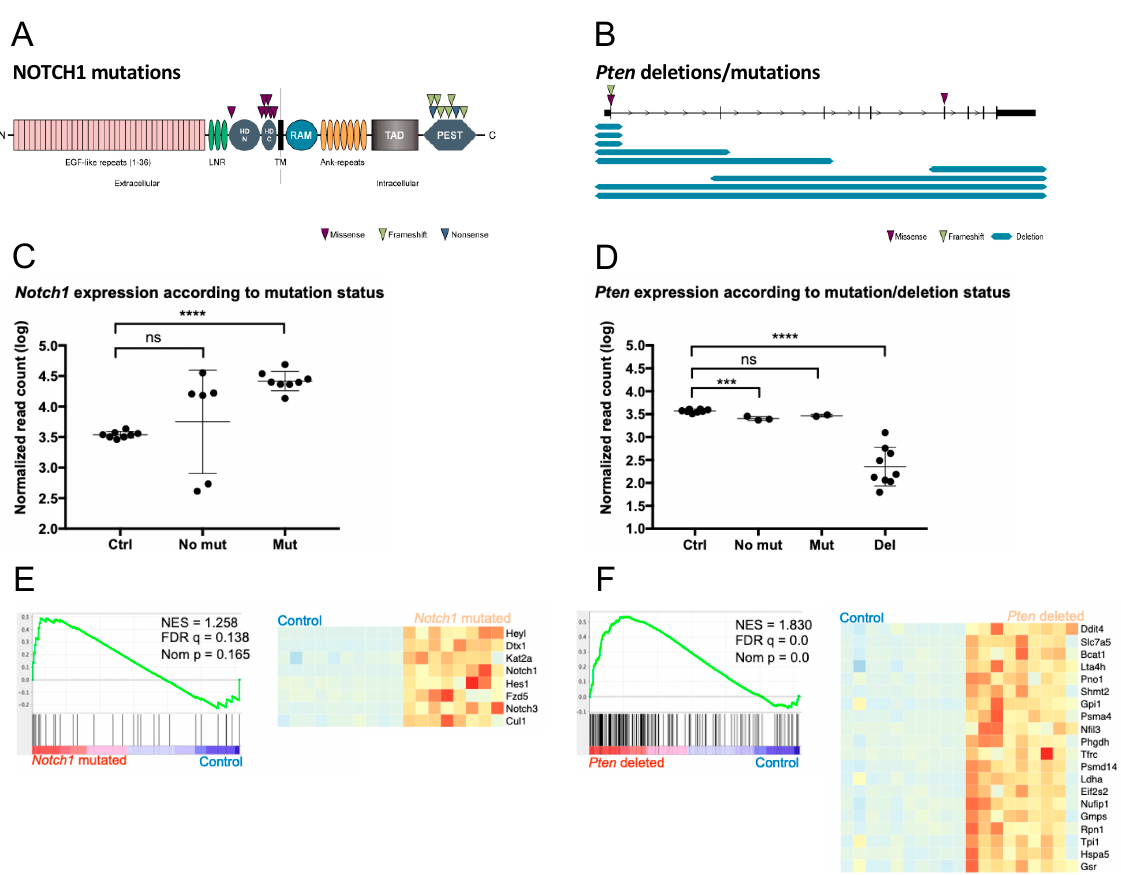
Figure 3. PPM1D -induced thymic lymphomas show typical Notch1 and Pten aberrations. ( A ) Schematic overview of the NOTCH1 protein showing the distribution of mutations in 15 whole-exome sequenced lymphomas. Purple triangles in- dicate missense mutations in the intracellular heterodimerization (HD) domain, whereas green and blue triangles indicate frameshift or nonsense mutations in the extracellular PEST domain. LNR, Lin/NOTCH repeats; HD, heterodimerization domain; TM, transmembrane domain; RAM, RBP-JK-associated molecule region; TAD, transactivation domain; PEST, se- quence rich in proline, glutamic acid, serine, and threonine. ( B ) Diagram of the Pten gene showing the size and distribution of Pten deletions/mutations in lymphomas. The locations of the point mutations are shown with purple and green triangles above the gene diagram. The blue lines below the gene diagram show the size of the deletions identified by exome se- quencing. ( C ) Expression of the Notch1 transcript in controls and tumors with and without Notch1 mutation. The y axis shows the log value of the number of RNA-seq reads mapping to the Notch1 gene. The difference between controls and tumors without Notch1 mutations is not significant (ns), whereas Notch1 expression is significantly higher in the mutated tumors (adjusted p value < 0.0001; Bonferroni multiple comparisons test). ( D ) Expression of Pten in controls and tumors with and without Pten mutation/deletion. Expression is significantly lower in tumors harboring deletions than in controls (adjusted p value 0.0001, Bonferroni multiple comparisons test). ( E ) Gene set enrichment analysis comparing Notch1 mu- tated tumors to controls demonstrated a significant upregulation of genes related to Notch signaling (MSigDB ”Hall- marks” gene set). Left panel: Enrichment plot from GSEA. Right panel: Heatmap showing the expression (z scores) of core enriched genes. Red color indicates positive z scores; blue color indicates negative z scores. ( F ) Gene set enrichment anal- ysis comparing Pten deleted tumors to controls demonstrated upregulation of genes related to the Mtorc1 pathway (MSigDB “Hallmarks” gene set). Left panel: Enrichment plot from GSEA. Right panel: Heatmap showing the expression (z scores) of the top 20 core enriched genes. Red color indicates positive z scores; blue color indicates negative z scores. 3. Discussion Aberrant expression of PPM1D caused by chromosomal gains, gene amplification, or activating mutations has been described in multiple cancers and high expression of PPM1D often correlates with poor patient prognosis [38]. Moreover, high expression and/or genetic aberration of PPM1D is frequently found in cancers with wt TRP53